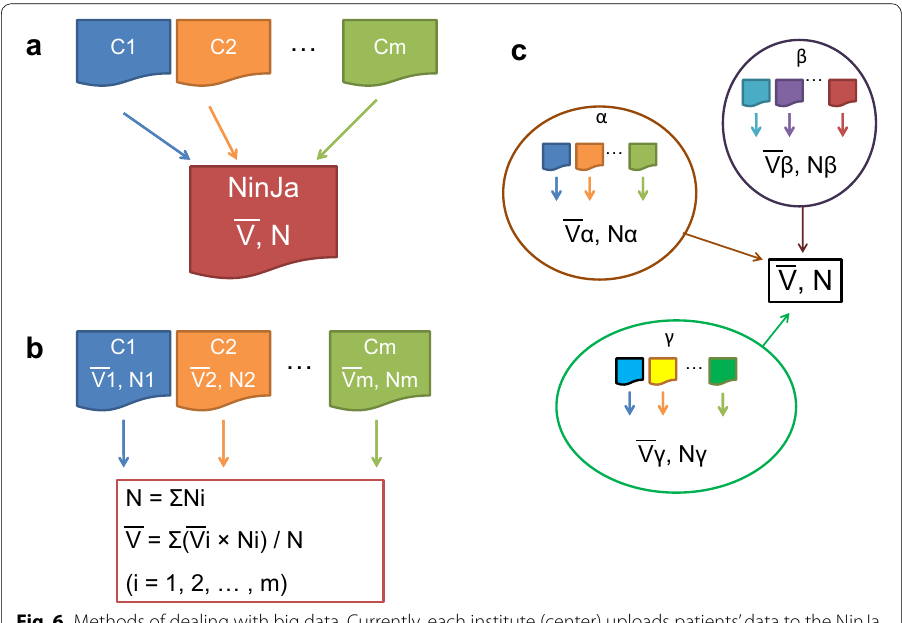
Fig. 6 Methods of dealing with big data. Currently, each institute (center) uploads patients’ data to the NinJa database and the mean vector is computed using the aggregated data ( a ); however, the mean vector can be calculated based on mean vectors and sample numbers which computed in each center independently ( b ). In the future, mean vectors from various regions or countries (α, β, γ) will be aggregated and the mean vector of big data can be obtained ( c